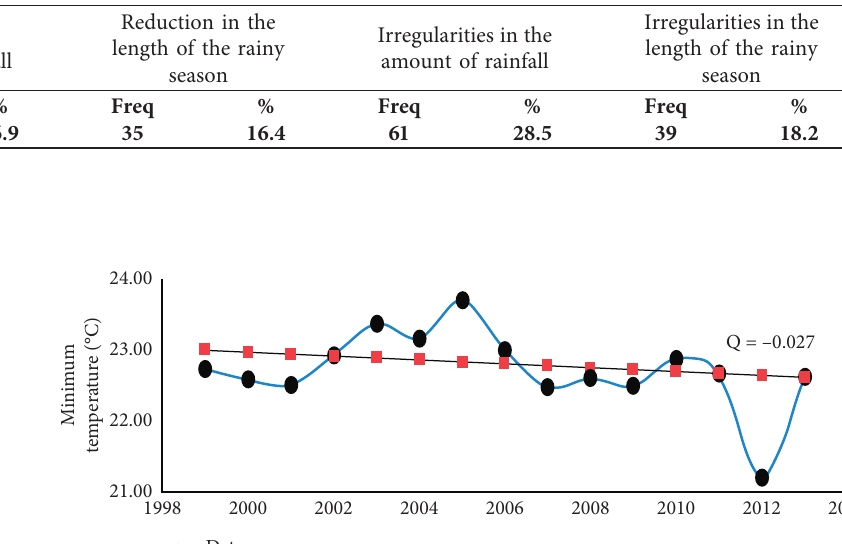
Table 2: Respondents’ observation of the manifestations of rainfall